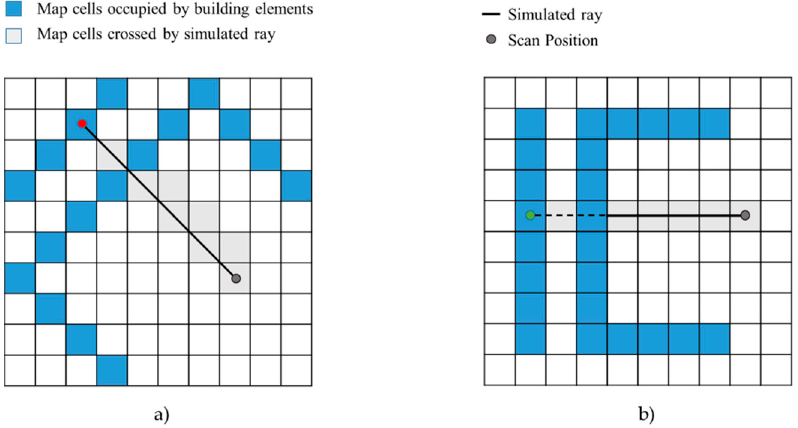
Figure 8. Bresenham algorithm is used to determinate the map cells that are crossed by simulated beam (gray) in visibility analysis. ( a ) target cell (red) is wrongly classified as visible since it is not occluded by other cells representing building elements, ( b ) target point (green) is correctly classified as occluded in the ray-casting